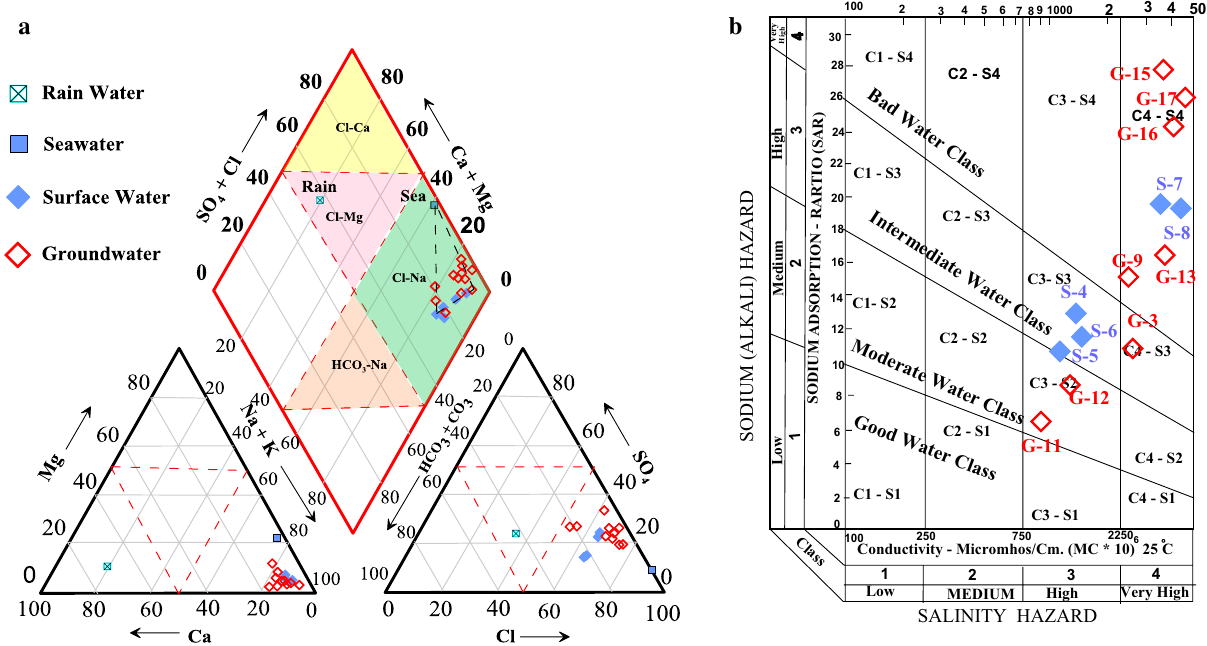
Fig. 5 a Piper diagram of the surface water and groundwater samples adjacent to El-Salam Canal. b The US salinity diagram for surface and groundwater adjacent to El-Salam Canal